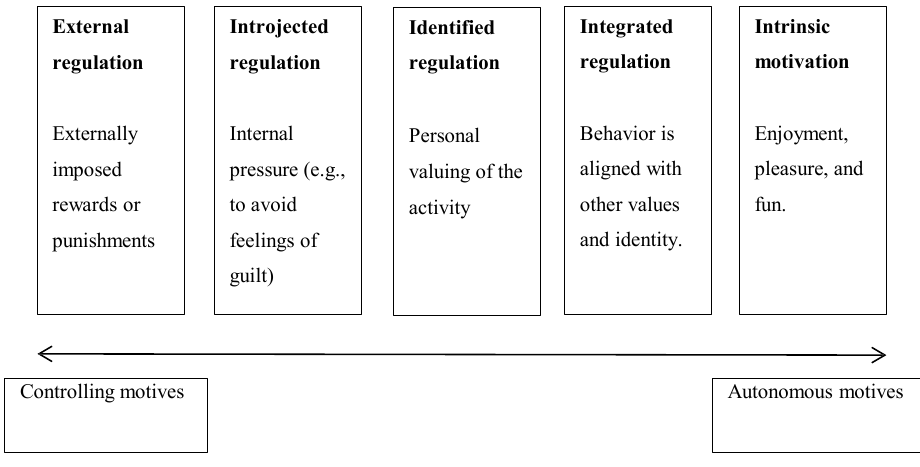
Figure 2. Motivations discussed in self-determination theory and their position in an Figure 2: Motivations discussed in self-determination theory and their position in autonomy continuum. an autonomy